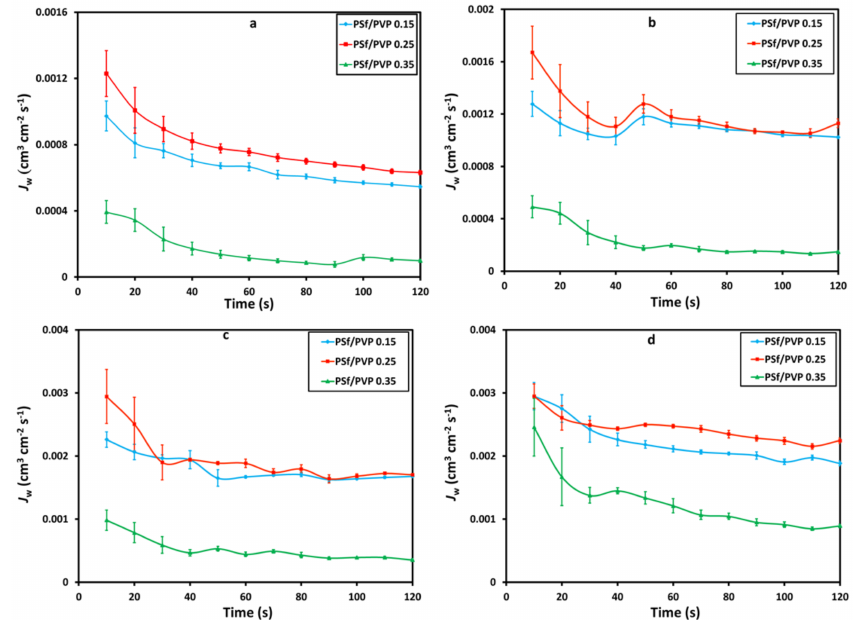
Figure 7. The profile of wastewater flux (cm 3 · cm − 2 · s − 1 ), J W , with time at feed pressure of ( a ) 4 bar,